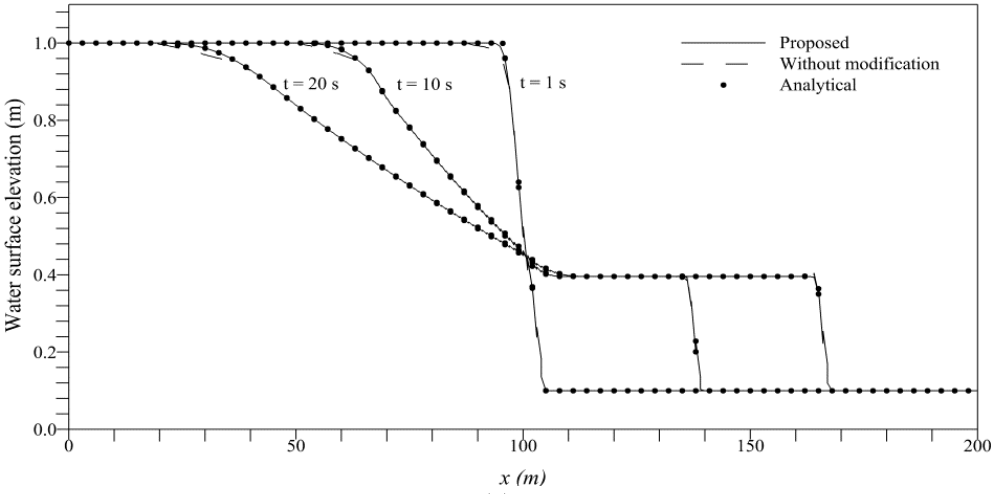
Figure 1. Cont. Figure 1.